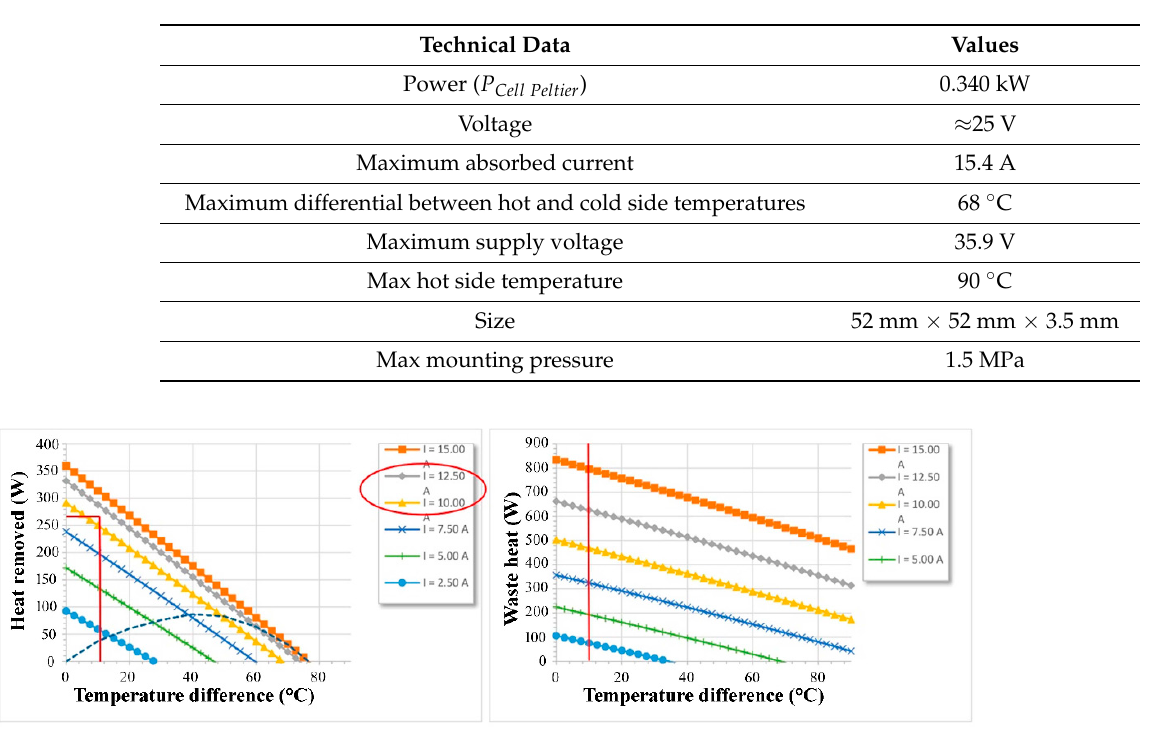
Figure 6. Performance of the Peltier cell selected.